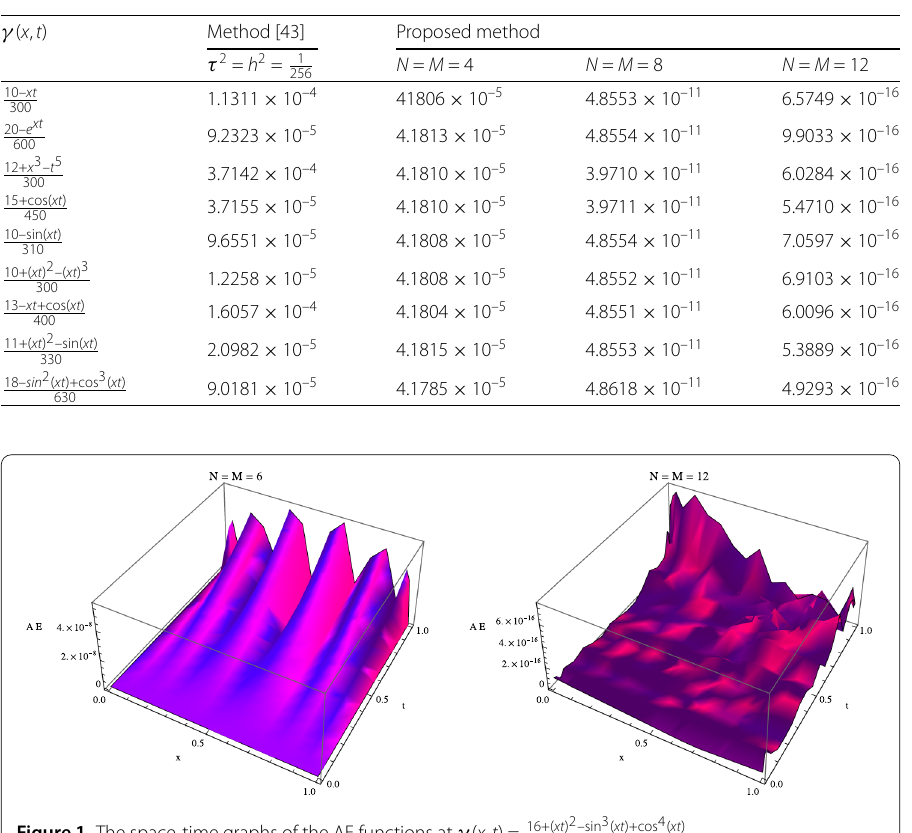
Table 1 The maximum absolute errors